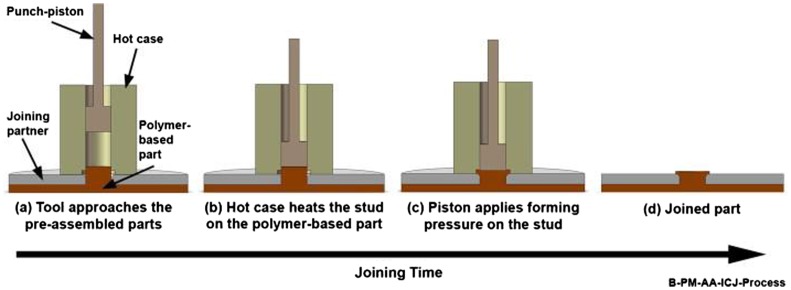
Steps of injection clinching process [178].